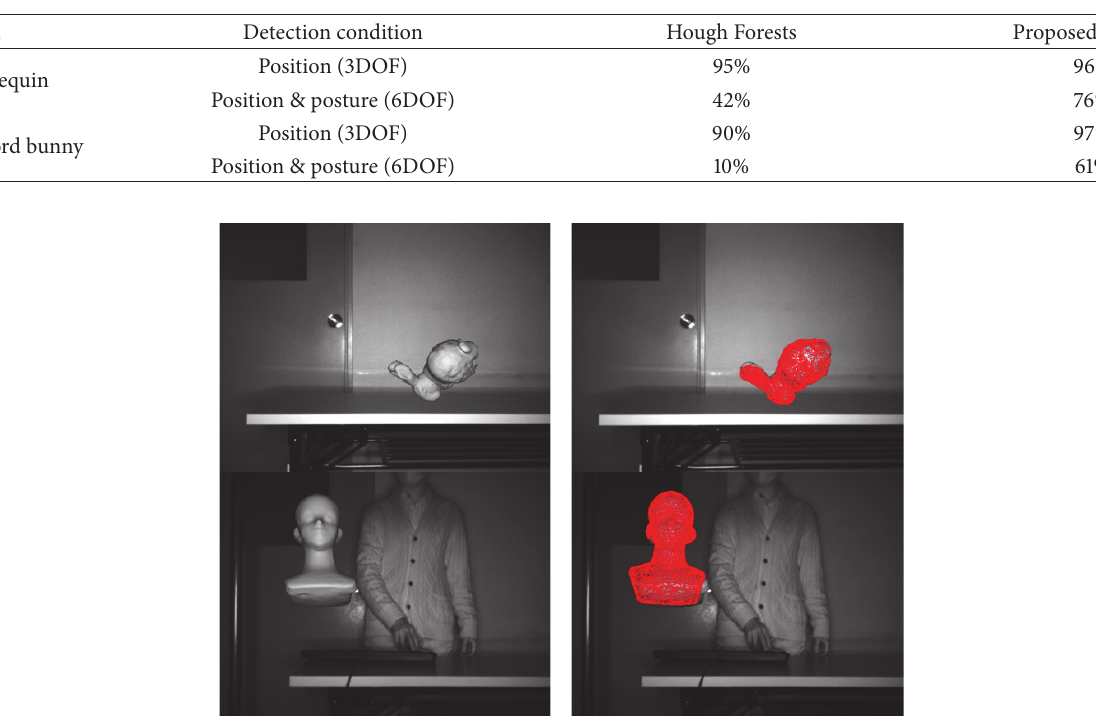
Table 1: Detection rate.